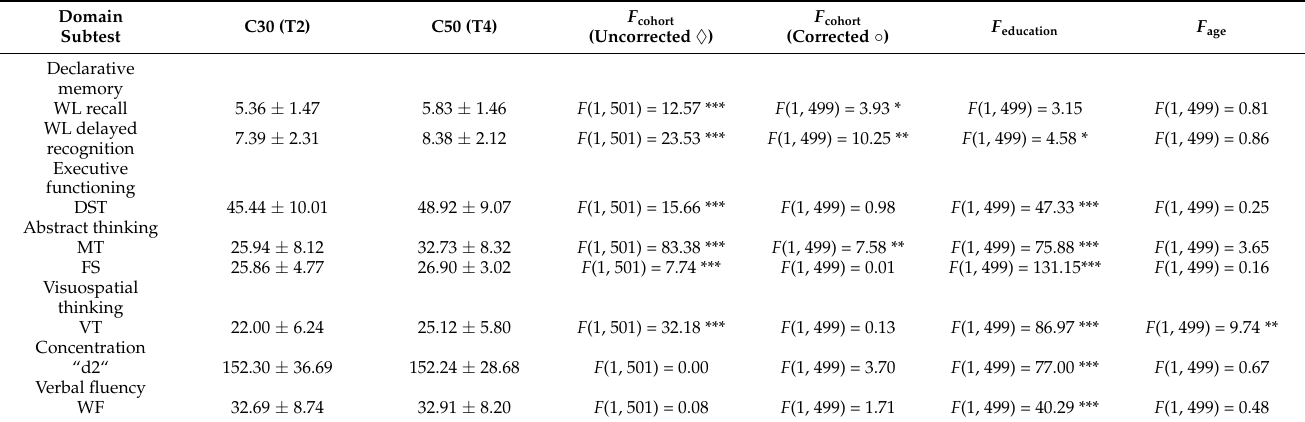
Table 2. Neuropsychological performance in the earlier- (C30) vs. the later (C50)-born